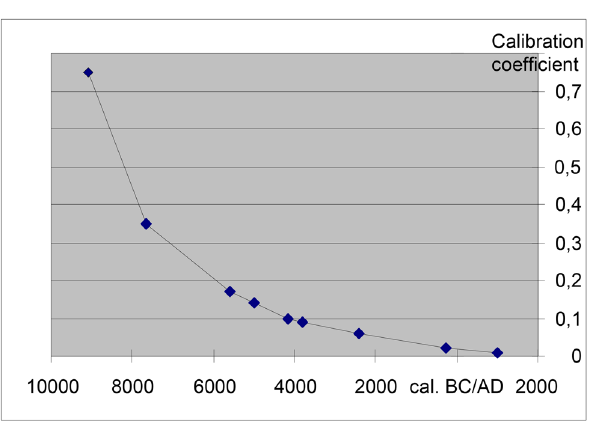
Figure A1: Sites in this article are dated by their position above present sea level and their distances to the “ base - isobar ” ( Figure 3 ) . The above calibration coe ffi cient is applied to adjust for the spatial variance in shore level changes in the region through time. The plot is based on a study by Tore Påsse ( 2003, pp. 48 – 49, Table 42 ) and redrawn by Per Persson,